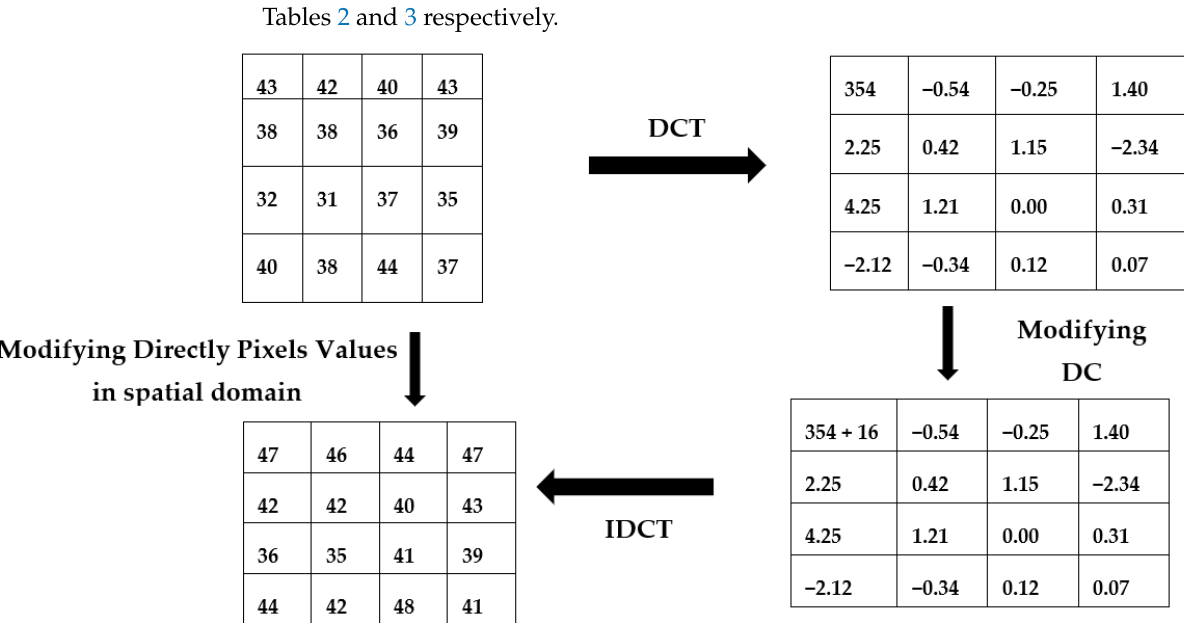
Figure 6. Relation between DC and Spatial Domain. Table 2. Calculation of DC Coefficient.